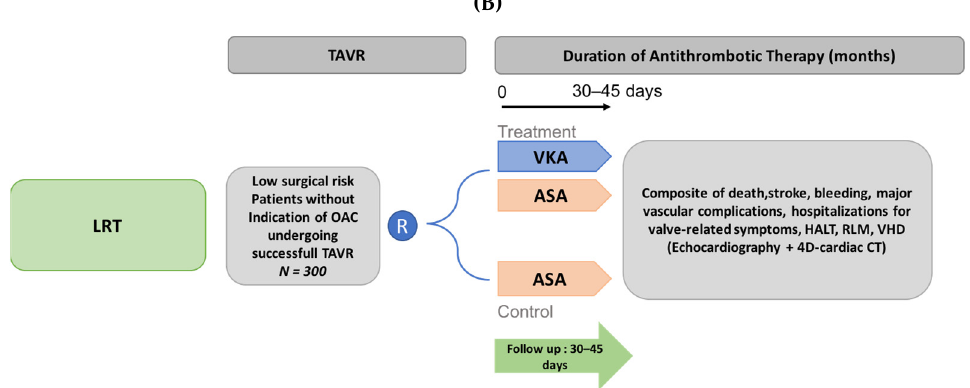
Figure 7. Design of ongoing trials of antithrombotic strategies in patients undergoing transcatheter aortic valve replacement with ( A ) and without ( B ) an indication for oral anticoagulation. 4D-CT: 4-dimensional computed tomography; ASA: aspirin; DOAC: direct oral anticoagulation; HALT: hypoattenuated leaflet thickening; MI: myocardial infarction; RLM: reduced leaflet motion; TAVR: transcatheter aortic valve replacement; VHD: valvular hemodynamic deterioration; VKA: Vitamin K antagonist; bd: bi-day; qd: quotidianly. ( A ) Patients with an underlying indication for OAC. ( B ). Patients without having an indication for